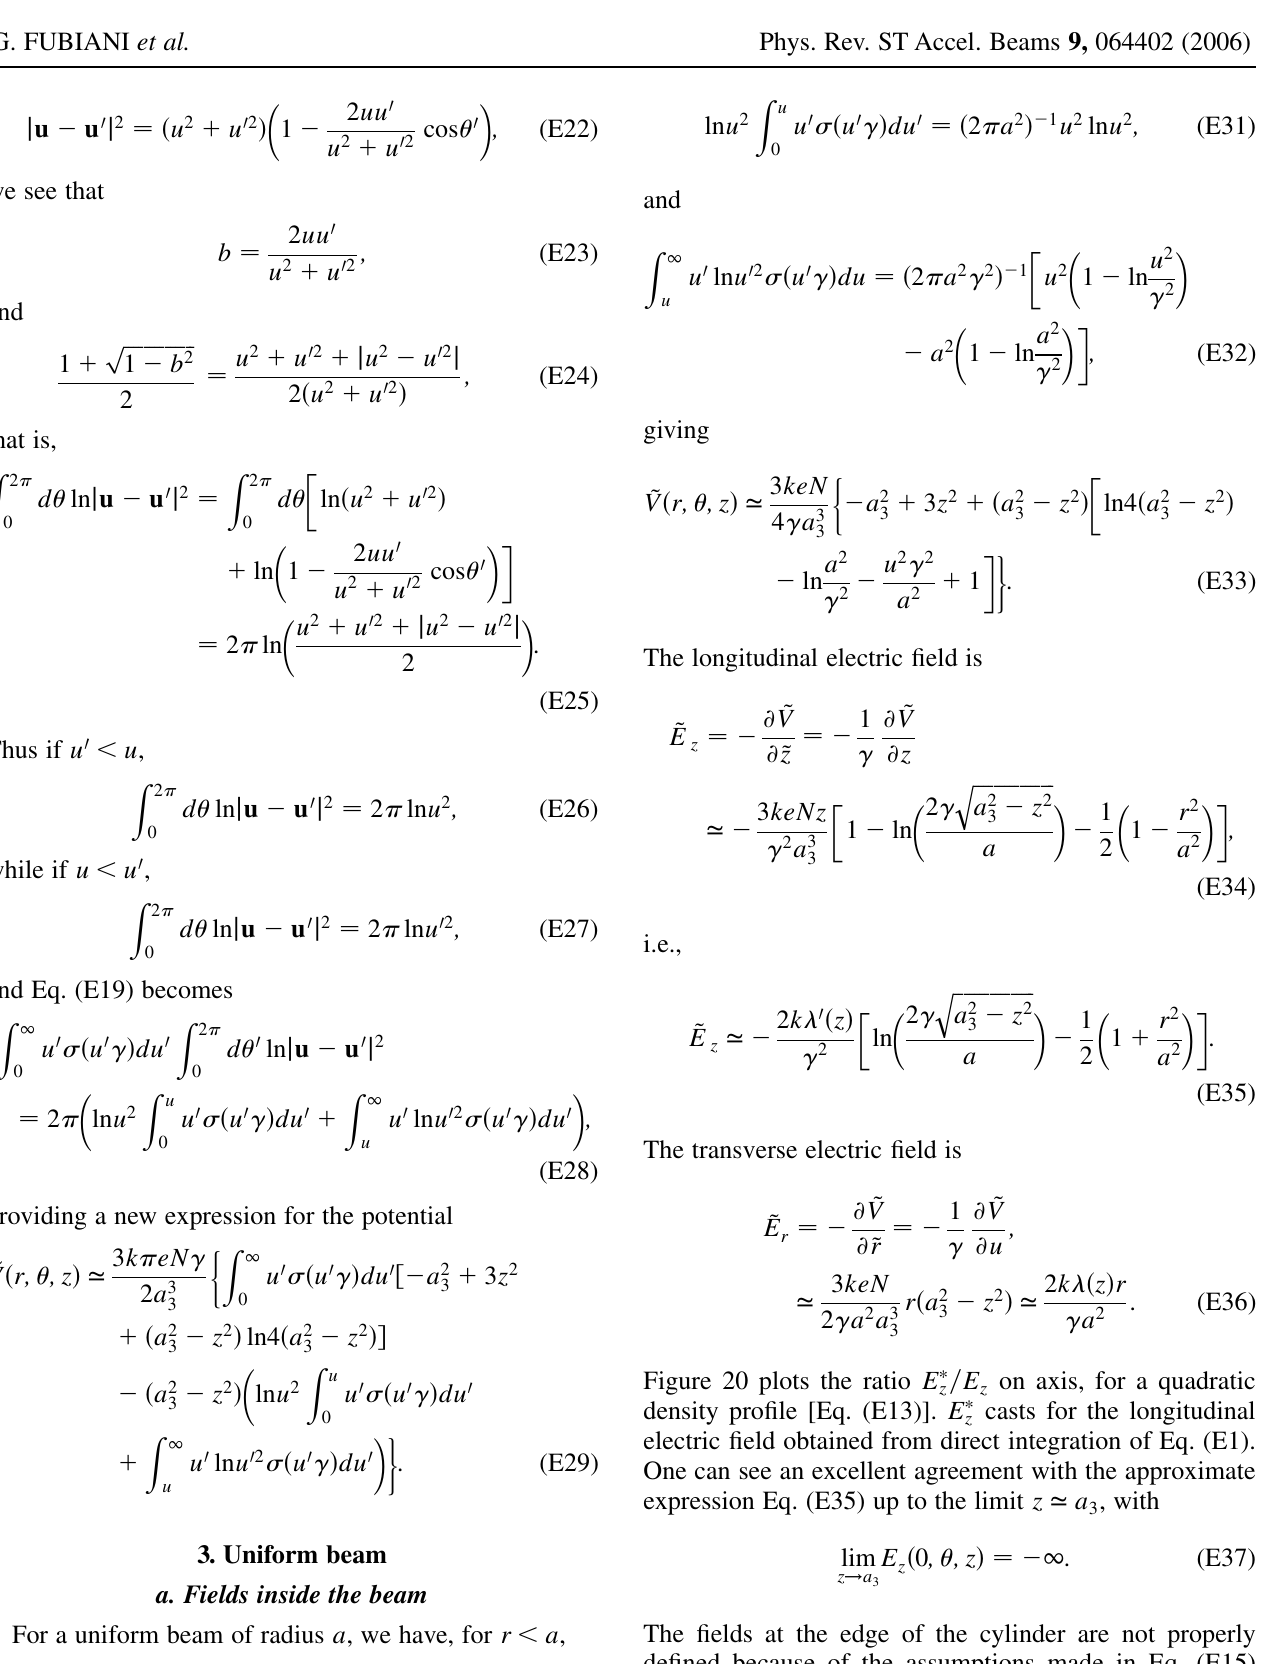
The fields at the edge of the cylinder are not properly defined because of the assumptions made in Eq. (E15) and (E16) that allow for an analytical solution to be